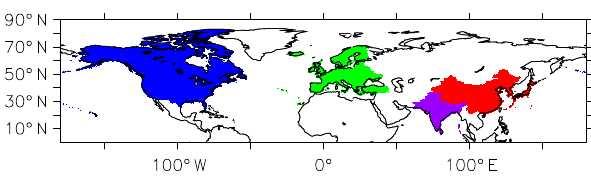
Figure 1. Regions addressed in this study, i.e., North America (blue), Europe (green), South Asia (purple) and East Asia (red).